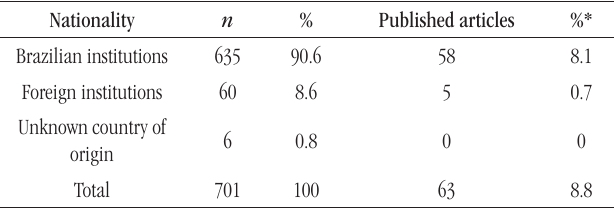
taBLE 3 − Relationship between absolute and relative values of the